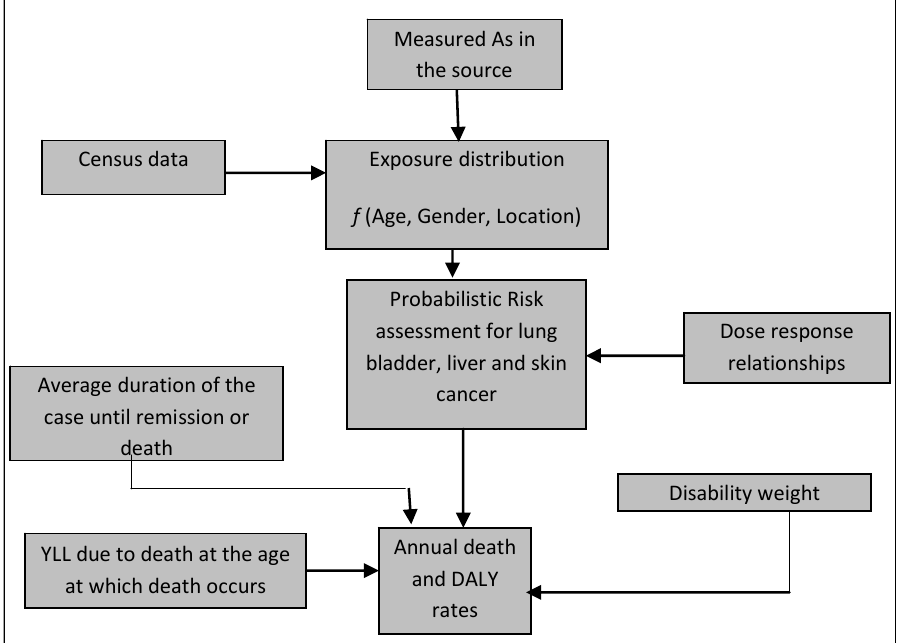
Figure 2. Schematic of the model for arsenic attributable health risks